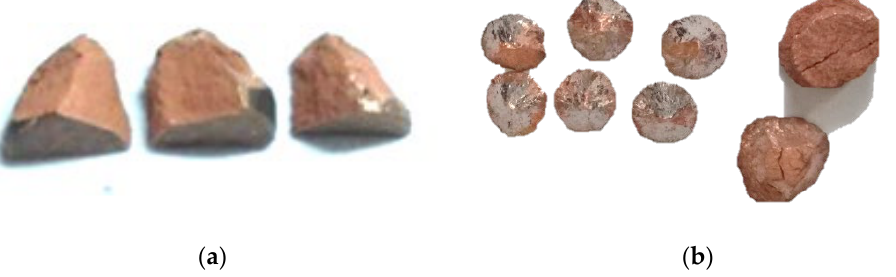
Figure 11. The remaining fragmentation of the actual ballistic testing ( a ) AMMO 1; ( b ) AMMO 2.